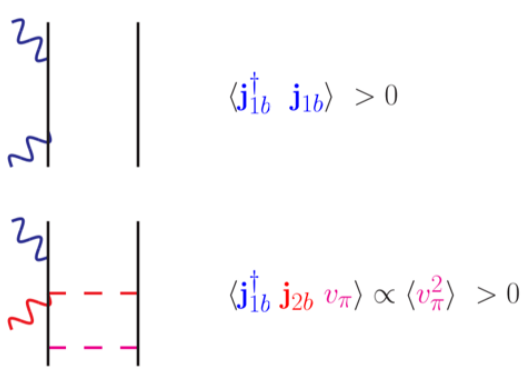
Figure 20.1: Lepton scattering via inherently two body objects is considered via chiral effective field theory Feynman diagrams in single and interference